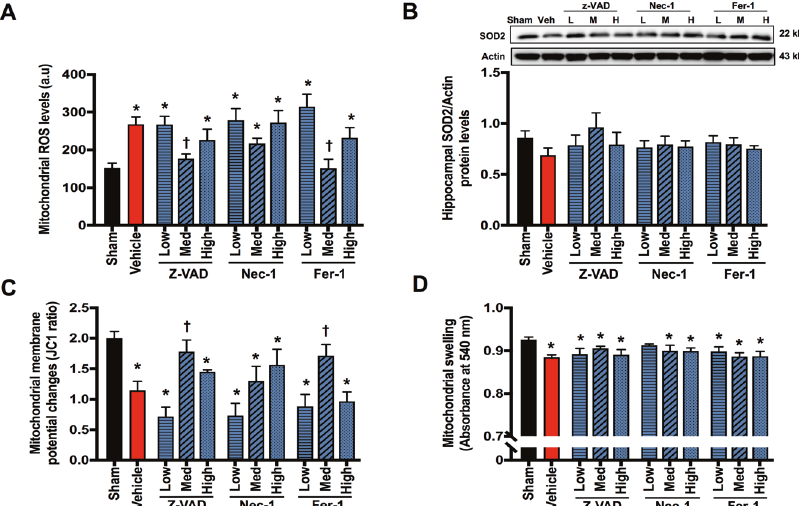
Fig. 2 The effects of cell death inhibitors on brain mitochondrial function and brain mitochondrial superoxide dismutase (SOD2) level. A Brain mitochondrial oxidative stress (ROS) level ( n = 8 – 12/group); B brain mitochondrial superoxide dismutase (SOD2) level ( n = 6/group); C brain mitochondrial membrane potential changes ( n = 8 – 12/group); D brain mitochondrial swelling ( n = 8 – 12/group). Data are shown as mean ± SEM. * P < 0.05 vs. Sham, † P < 0.05 vs . Cardiac I/R + Vehicle. Veh: cardiac I/R rats treated with vehicle; L: cardiac I/R rats treated with low dose of cell death inhibitor; M: cardiac I/R rats treated with medium dose of cell death inhibitor; H: cardiac I/R rats treated with high dose of cell death inhibitor. I/R ischemia/reperfusion injury.